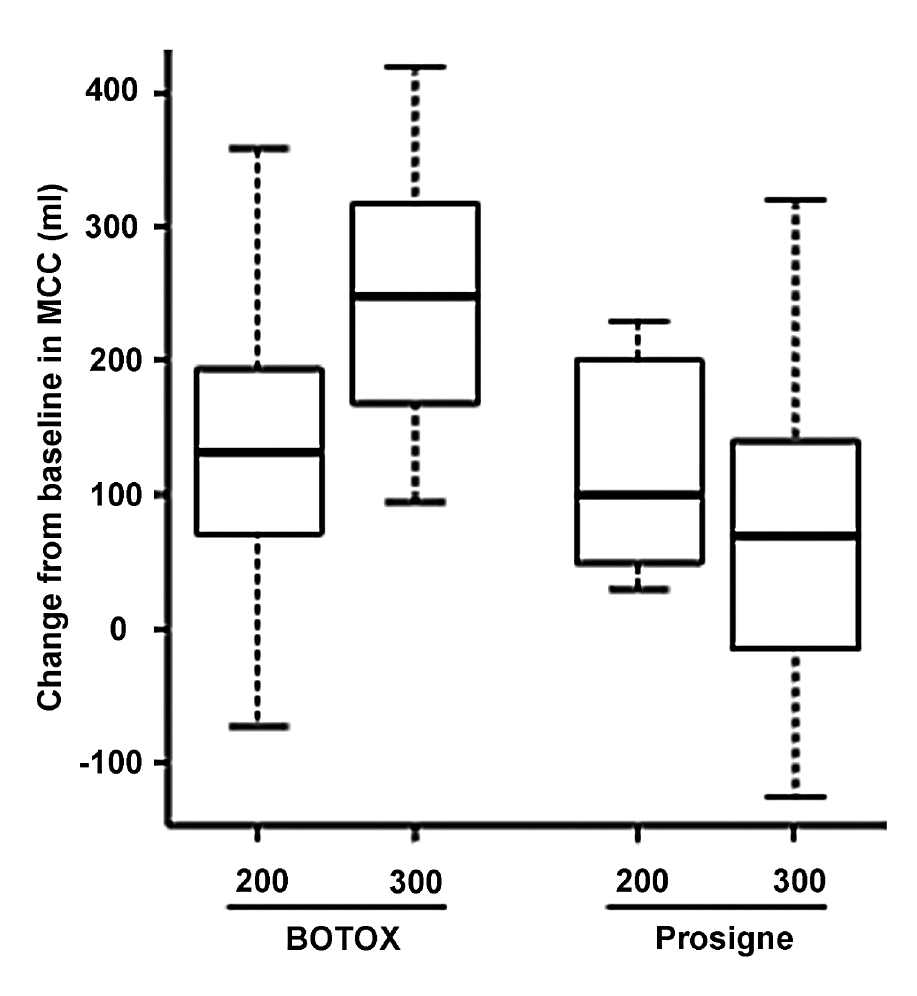
Figure 2 – Box-plot analysis of change from baseline in maximum cystometric capacity (MCC) at week 12, according to treatment group and dose level (200 or 300